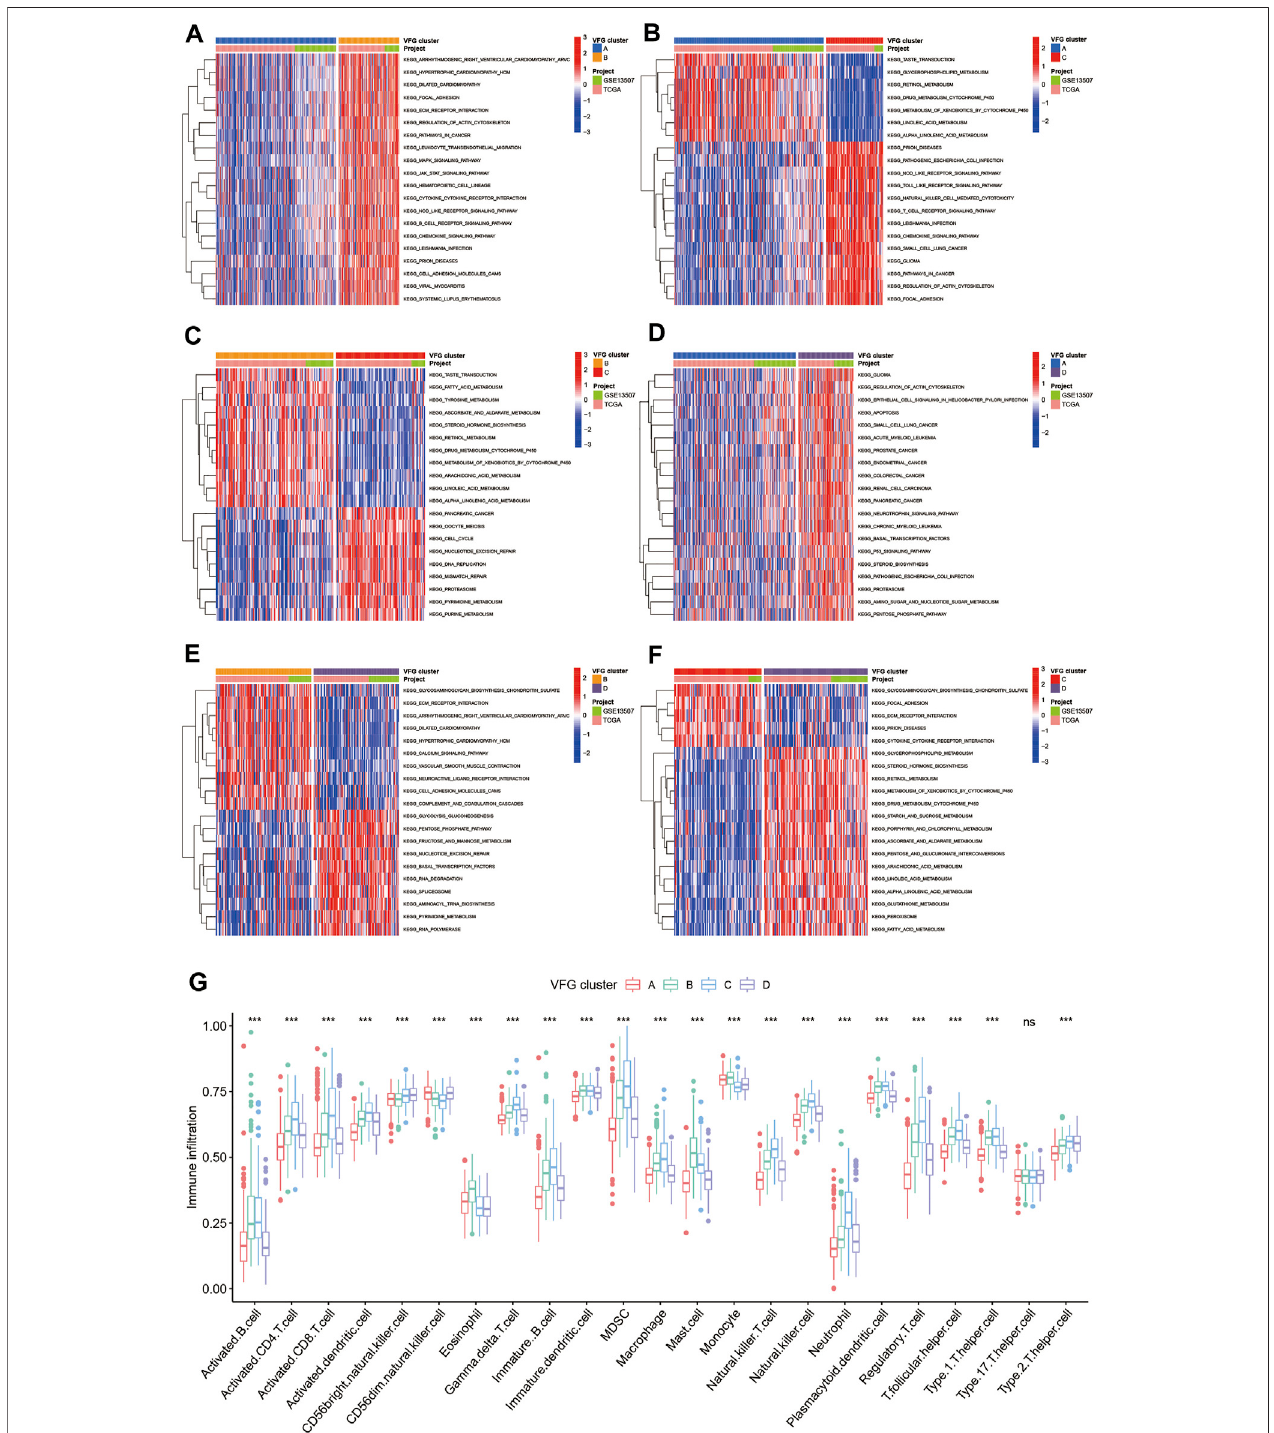
FIGURE 3 | TME cell in fi ltration characteristics in distinct VFG patterns. (A – F) GSVA enrichment analysis showing the activation states of biological pathways in distinct ferroptosis patterns. The heatmap was used to visualize these biological processes, and red represented activated pathways and blue represented inhibited pathways. The project and VFGclusters were used as sample annotations. (A) VFGcluster A vs. VFGcluster B; (B) VFGcluster A vs. VFGcluster C; (C) VFGcluster B vs. VFGclusterC; (D) VFGclusterAvs.VFGclusterD; (E) VFGclusterBvs.VFGclusterD; (F) VFGclusterCvs.VFGclusterD. (G) TheabundanceofeachTMEin fi ltrating cell in four ferroptosis patterns. The upper and lower ends of the boxes represented interquartile range of values. The lines in the boxes represented median value, and black dots showed outliers. The asterisks represented the statistical p value (* p < 0.05; ** p < 0.01; *** p < 0.001).